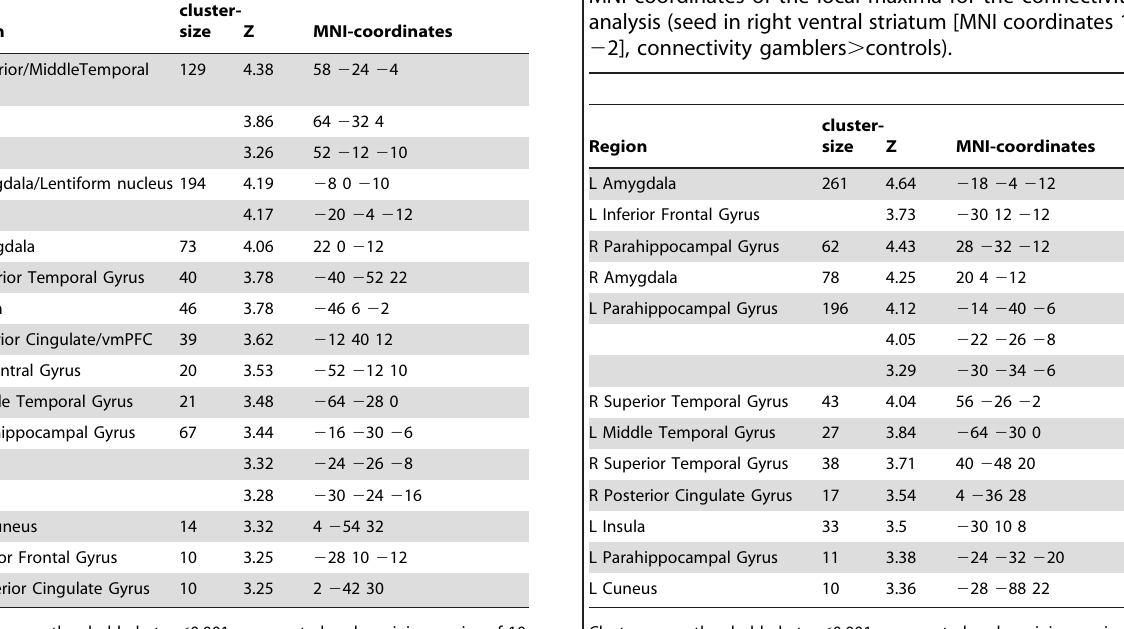
Clusters were thresholded at p , 0.001 uncorrected and a minimum size of 10